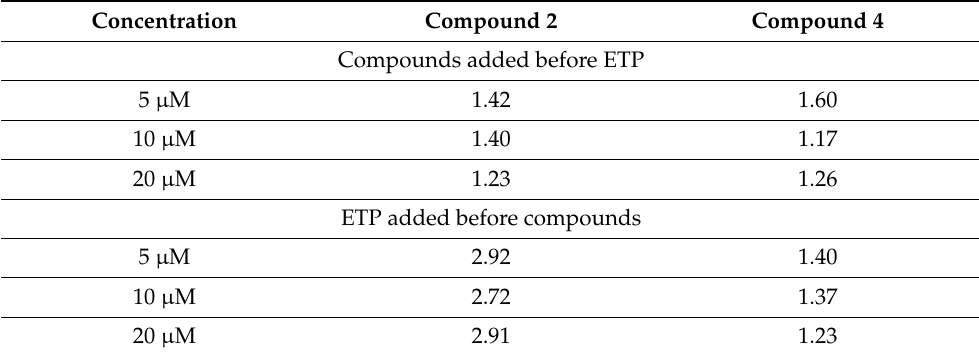
Table 3. Evaluation of genotoxic effects of compounds in comparison with ∑ ETP + pyridocarbazoles. The result was expressed as the proportion to the sum of ETP and pyridocarbazole caused damage made in three tests, where the reference value for the sum of etoposide and pyridocarbazoles was E ETP + PYR =